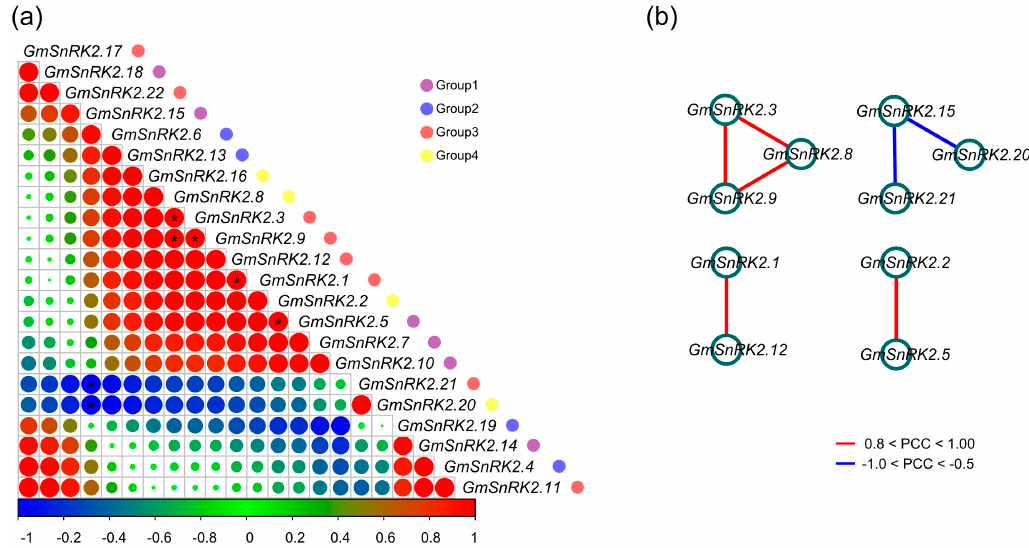
Figure 6. Correlations and co-regulatory networks of GmSnRK2 genes under ABA treatment. ( a ) Correlation analysis of GmSnRK2 genes under ABA treatments were performed based on the PCCs of gene pairs calculated using R package program. Correlations were indicated by the size and color of circles. Below bar represented the correlation values of PCCs. Red and blue indicate positive correlation and negative correlation, respectively. Gene name was listed at the right. Group 1, Group 2, Group 3 and Group 4 were marked as purple, blue, red and yellow circles, respectively. Black star represented the correlation with p -value ≤ 0.05; ( b ) co-regulatory network of GmSnRK2s under ABA treatment was illustrated by Cytoscape. The significant PCCs of gene pairs ( p -value ≤ 0.05) were included, and the different correlation levels of gene pairs were marked by edge line with different colors as showed below the co-regulatory networks.